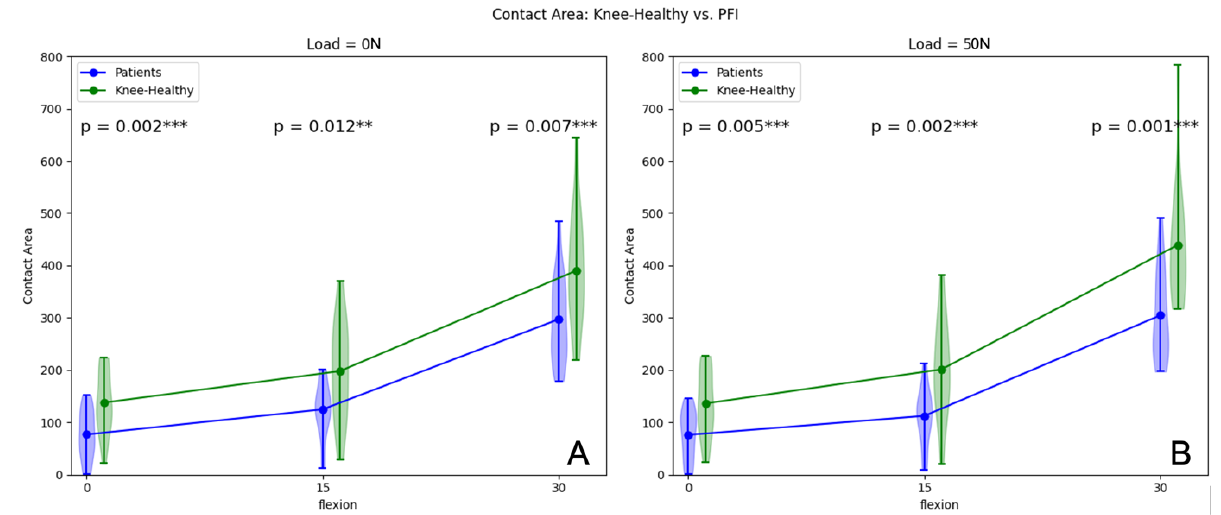
Figure 4. Patellofemoral CCA in unloaded ( A ) and loaded (50 N) situations ( B ) of patients and vol- unteers from 0° to 30° flexion. ** p -values < 0.05, *** p -values < 0.01. Table 3. Overview of parameters (mm 2 ) without and with quadriceps activation (50